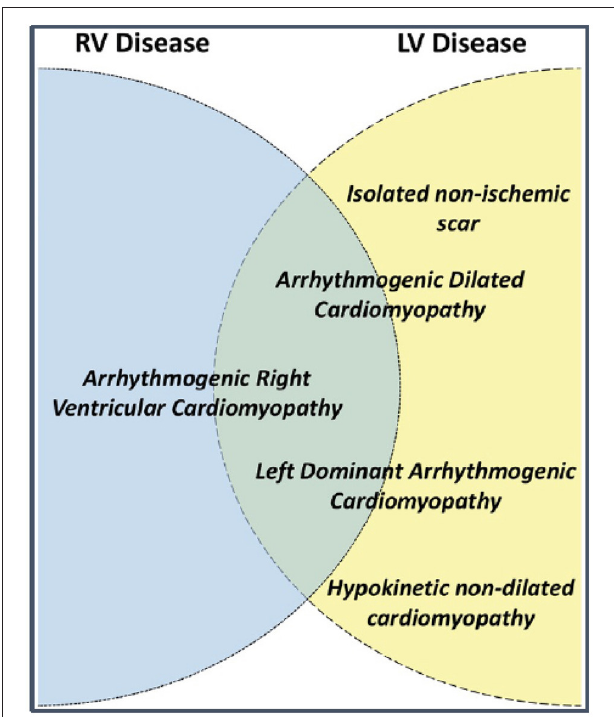
FIGURE 1 | Terms used to describe different arrhythmogenic cardiomyopathy phenotypes and their possible relationship to left (LV) and right ventricular (RV) disease. Source: ( 1), obtained with